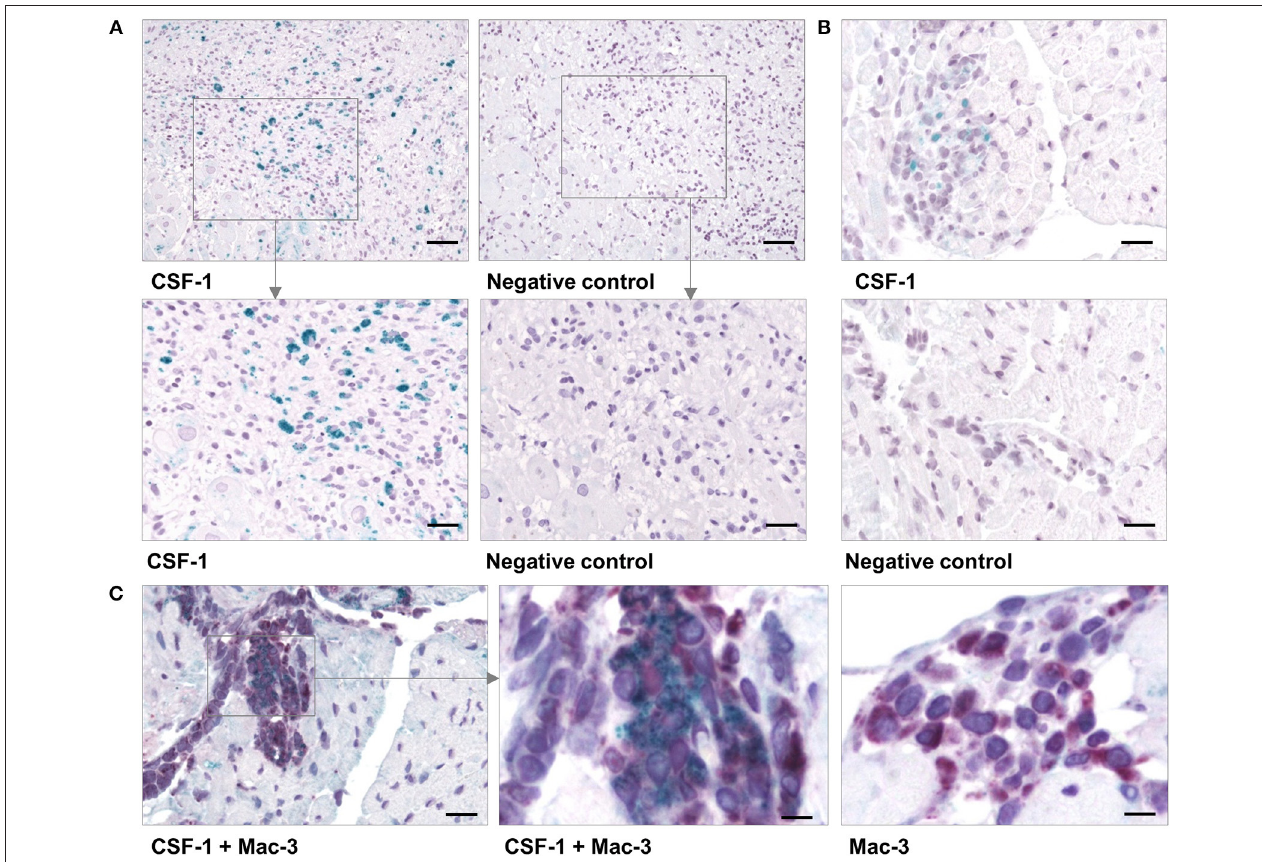
FIGURE 2 | CSF-1 production in cardiac tissue during viral myocarditis. Paraffin-embedded tissue sections from endomyocardial biopsies that had been obtained from patients with acute myocarditis were stained by immunohistochemistry. (A) Representative micrographs stained with an anti-CSF-1 antibody [left column] or with a secondary antibody only [right column] are depicted. top: scale bar = 120 µ m; bottom: scale bar = 60 µ m. (B) Heart tissue sections were obtained from CVB3-infected A.BY/SnJ mice on day 8 p .i. Representative micrographs of anti-CSF-1 stained heart tissue are shown [scale bar = 36 µ m]. (C) In addition, cardiac sections from mice were double-stained with an antibody directed against Mac-3 (red) [left: scale bar = 36 µ m; center: scale bar = 12 µ m] and against CSF-1 (green). As control, Mac-3 stained tissue sections were counterstained omitting the anti-CSF-1 directed antibody [right: scale bar = 12 µ